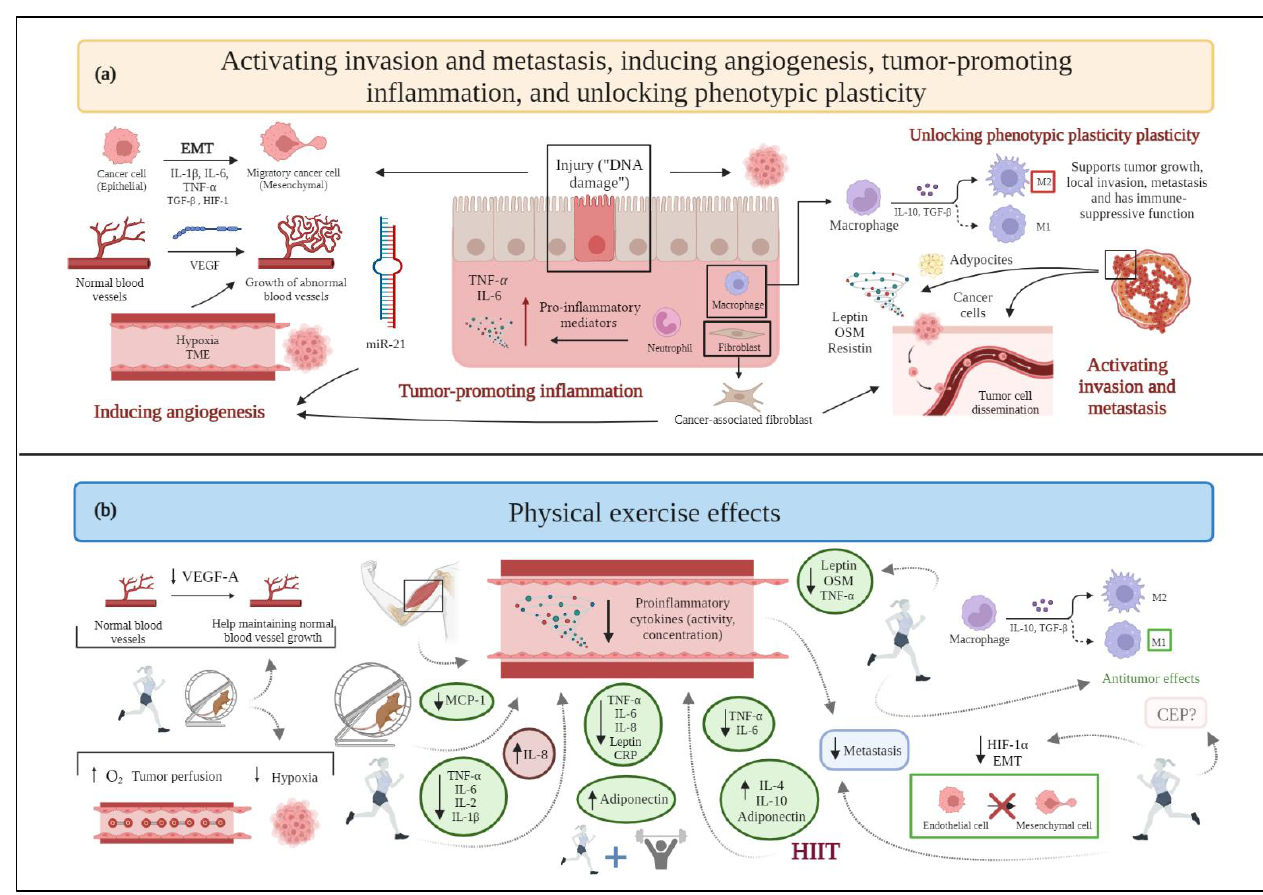
Figure 2. ( a ) Schematic drawing of cancer hallmarks, highlighting markers related to activating invasion and metastasis, inducing angiogenesis, tumor-promoting inflammation, and unlocking phenotypic plasticity. ( b ) The effects of physical exercise on activating invasion and metastasis, inducing angiogenesis, tumor-promoting inflammation, and unlocking phenotypic plasticity. Abbreviations: CEP: endothelial progenitor cells; EMT: epithelial to mesenchymal transition; HIF-1: hypoxia-inducible factor-1; HIF-1 α : hypoxia-inducible factor-1 α ; HIIT: high-intensity interval training; IL-1 β : interleukin-1 β ; IL-2: interleukin-2; Il-4: interleukin-4; IL-6: interleukin-6; IL-8: interleukin-8; IL-10: interleukin-10; MCP-1: monocyte chemoattractant protein-1; miR21: microRNA 21; OSM: oncostatin M; TGF- β: transforming growth factor - β; TNF - α: tumor necrosis factor- α; VEGF: vascular endothelial growth factor; VEGF-A: vascular endothelial growth factor-A.